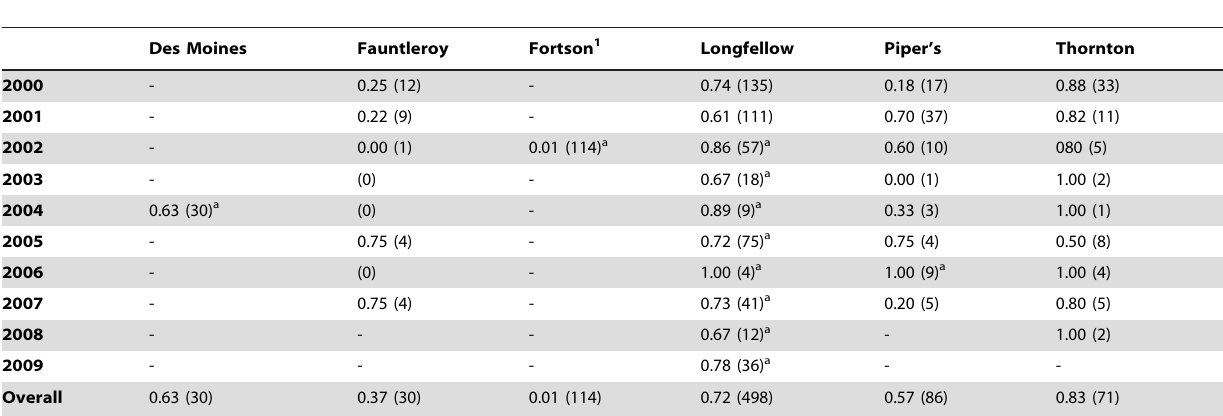
Table 1. Coho spawner mortality proportion and cumulative number of female carcasses enumerated (in parentheses) by site (columns) and year